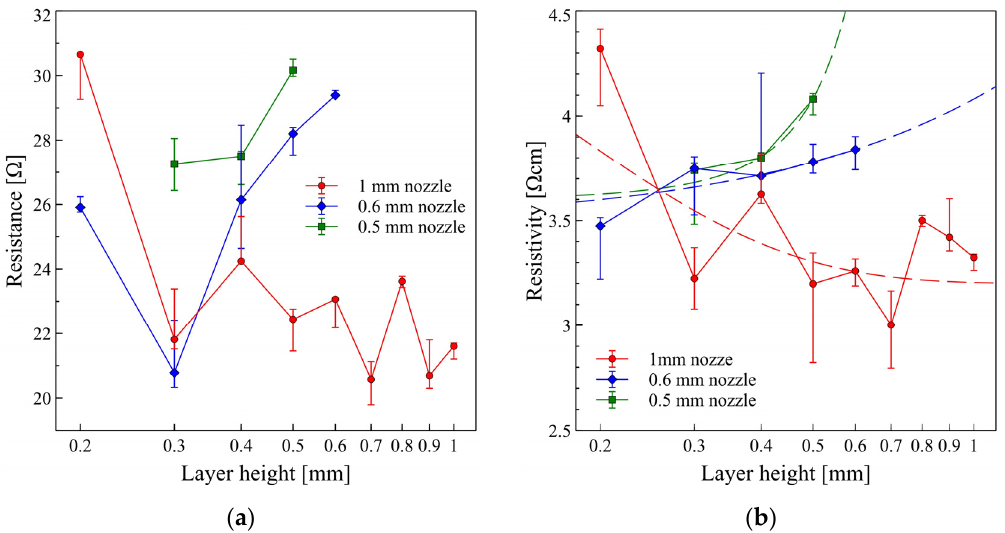
Figure 4. ( a ) Results of the resistance measurements of the samples printed with nozzle diameters from 0.5 to 1 mm, and wide range of layer thickness. ( b ) Calculated resistivity values for the same samples.